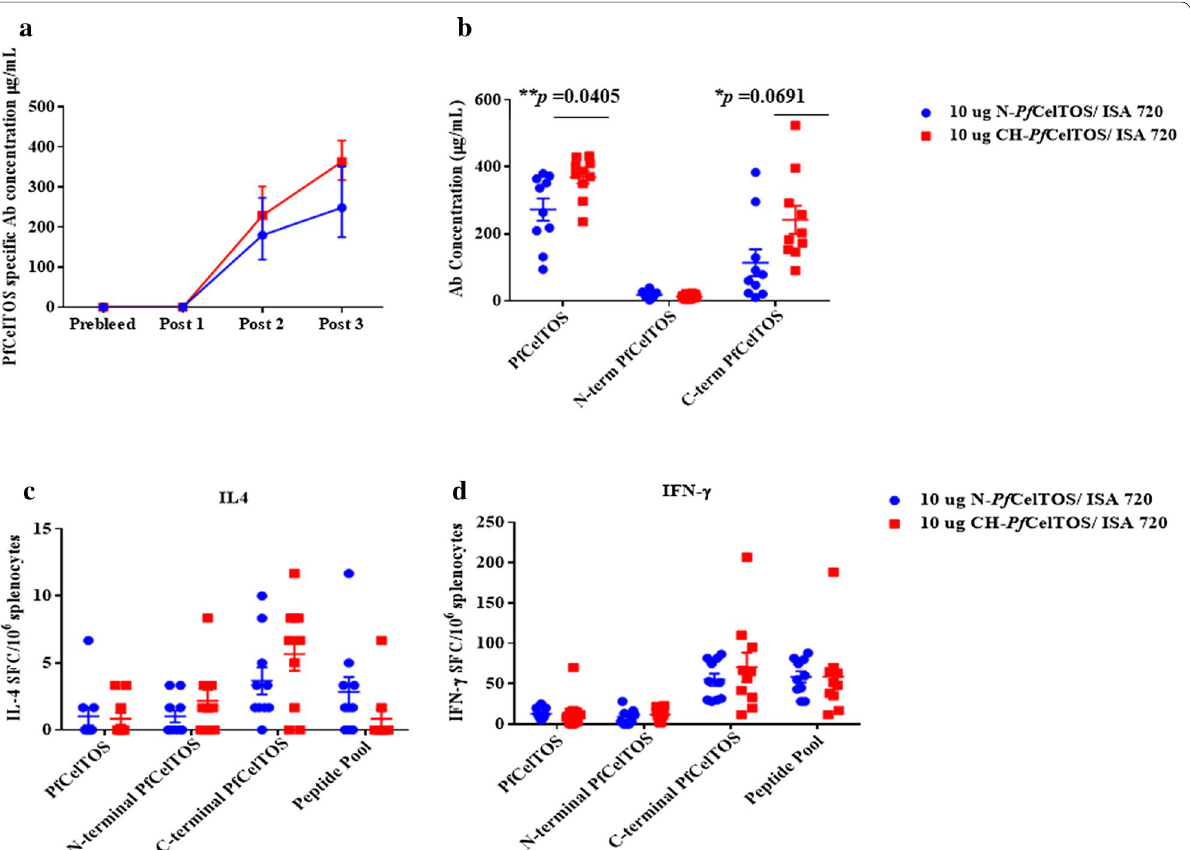
Fig. 6 N- Pf CelTOS and CH- Pf CelTOS induce comparable antibody and TH1 biased cellular responses. a Kinetic of Pf CelTOS specific antibody responses, reported as antigen specific concentrations (µg/mL). Geometric means and 95% confidence interval are reported. b Scatter plot of individual mouse responses at 2 weeks post 3rd immunization reported as the mean and standard deviation. Statistical significance of differences in antibody responses induced by N- Pf CelTOS and CH- Pf CelTOS was determined using Parametric, two tailed, unpaired T-test (**p